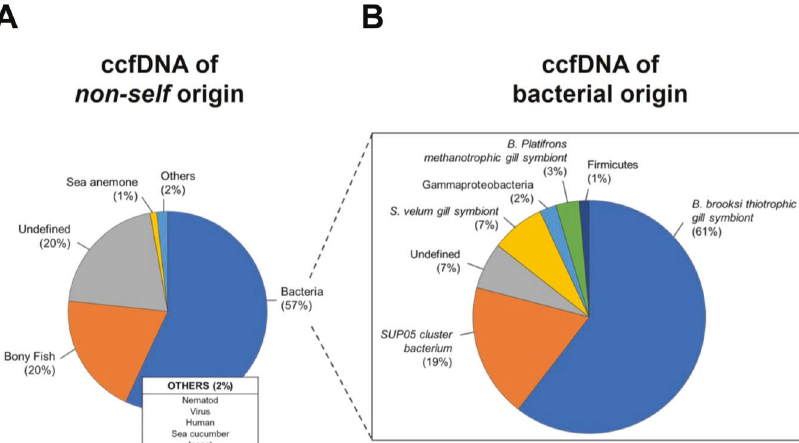
Fig. 5 ccfDNA of various origins as identi fi ed using BLASTN and BLASTX. A total of 482 assembled contigs were analyzed. A Overall taxonomic distribution pro fi le of metagenomic contig annotation (prokaryotes and eukaryotes). B Detailed distribution of bacterial DNA fragments identi fi ed using BLASTN and BLASTX.